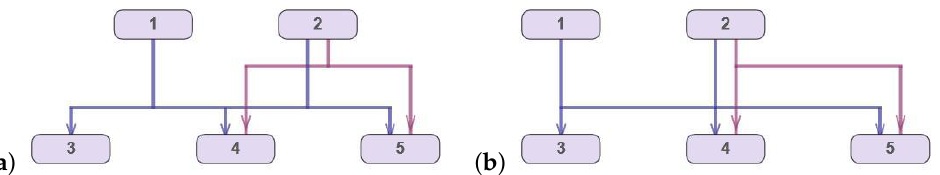
Figure 5. Layout of a hypergraph with ports for the source and target nodes: ( a ) non-optimal layout; ( b ) optimal layout with